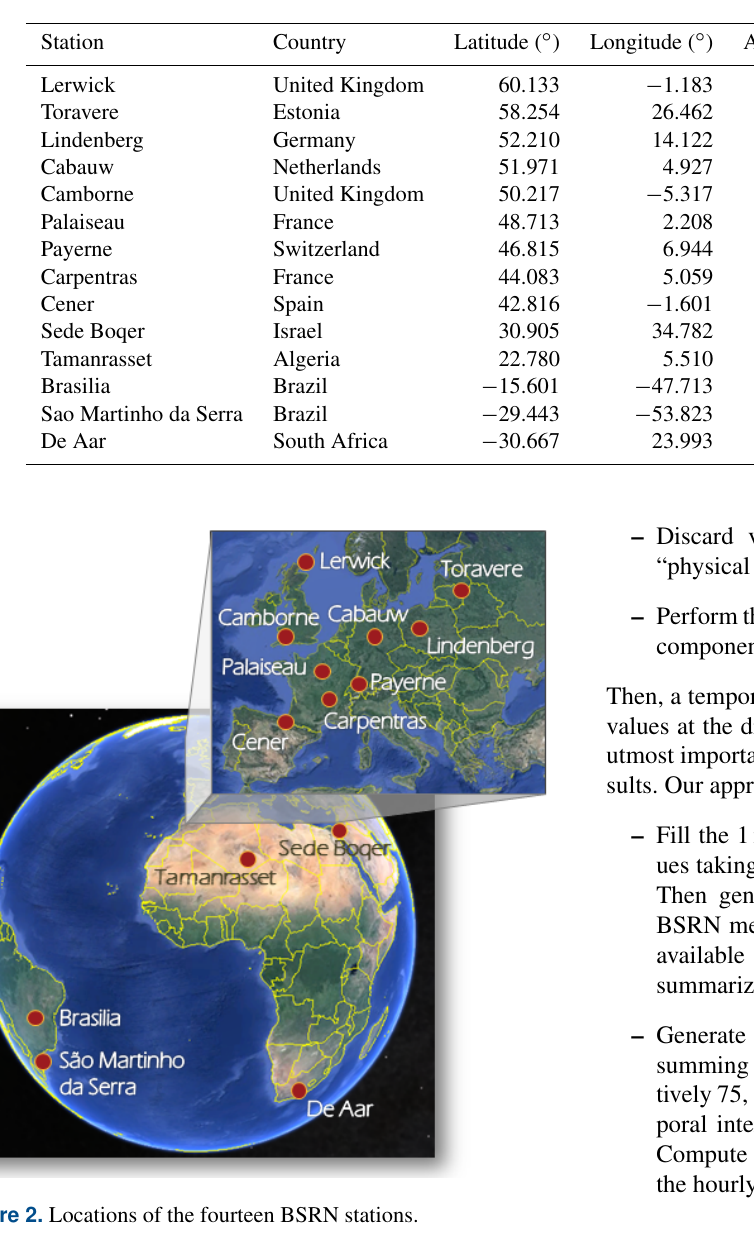
Figure 2. Locations of the fourteen BSRN stations.